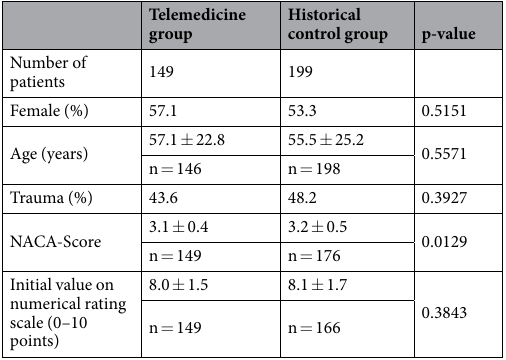
Table 1. Patient characteristics and demographics. (SD = standard deviation; CI = Confidence Interval). Parameters are displayed as numbers, percentages and means ± standard deviation.